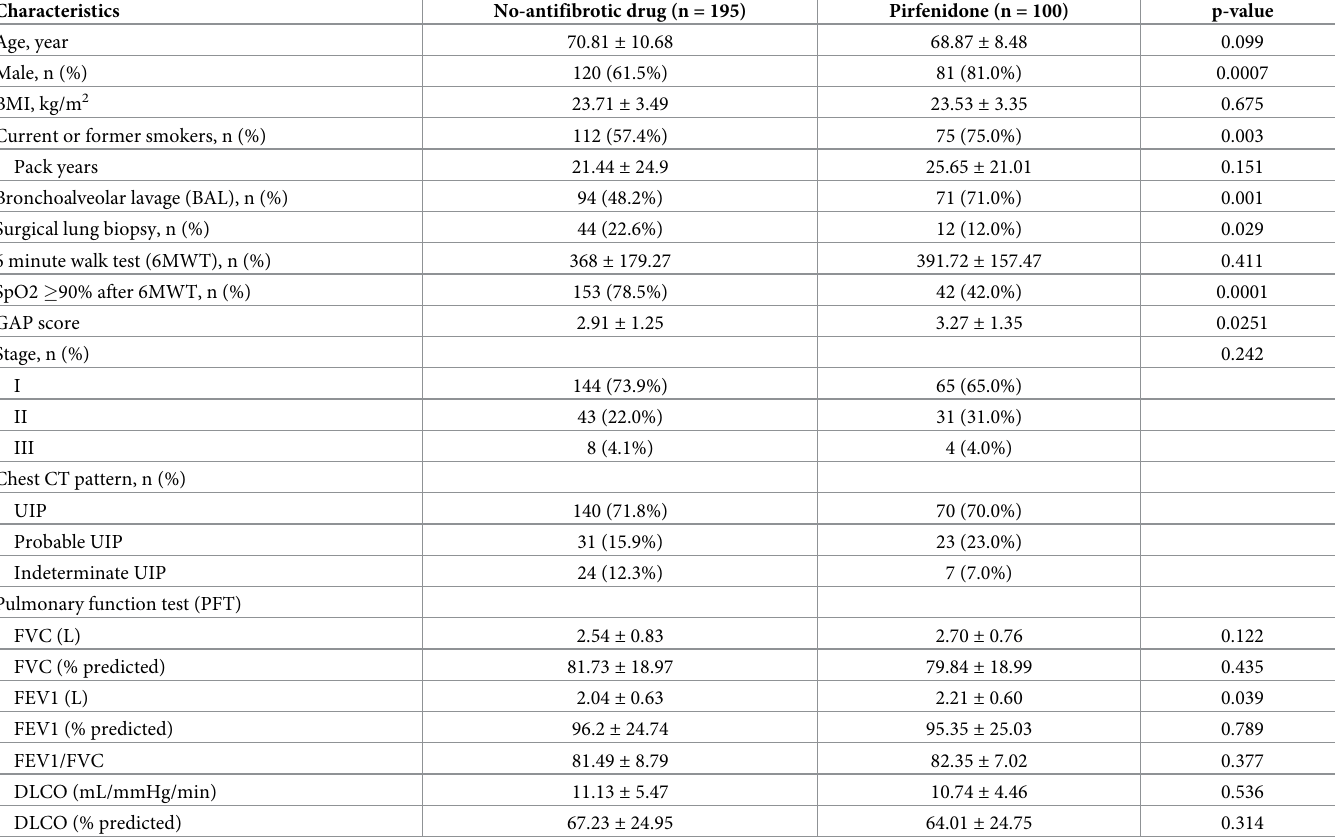
Table 1. Baseline epidemiological and clinical characteristics of the enrolled patients.